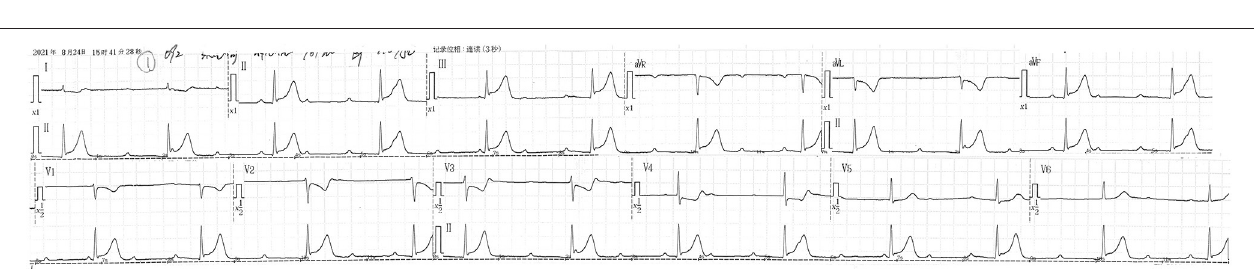
FIGURE 2 | The electrocardiogram identified a third-degree atrioventricular